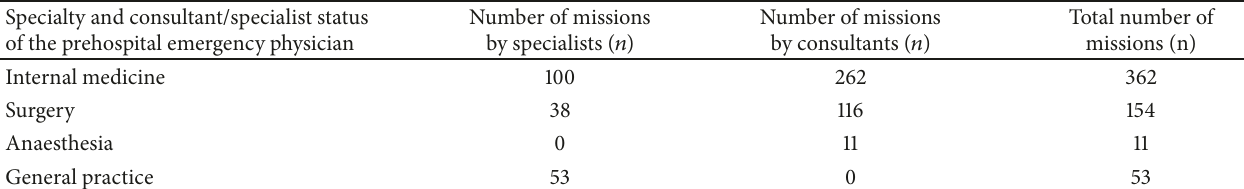
Table 1: Listing of the mission distribution according to specialty and consultant/specialist status of the prehospital emergency physician.